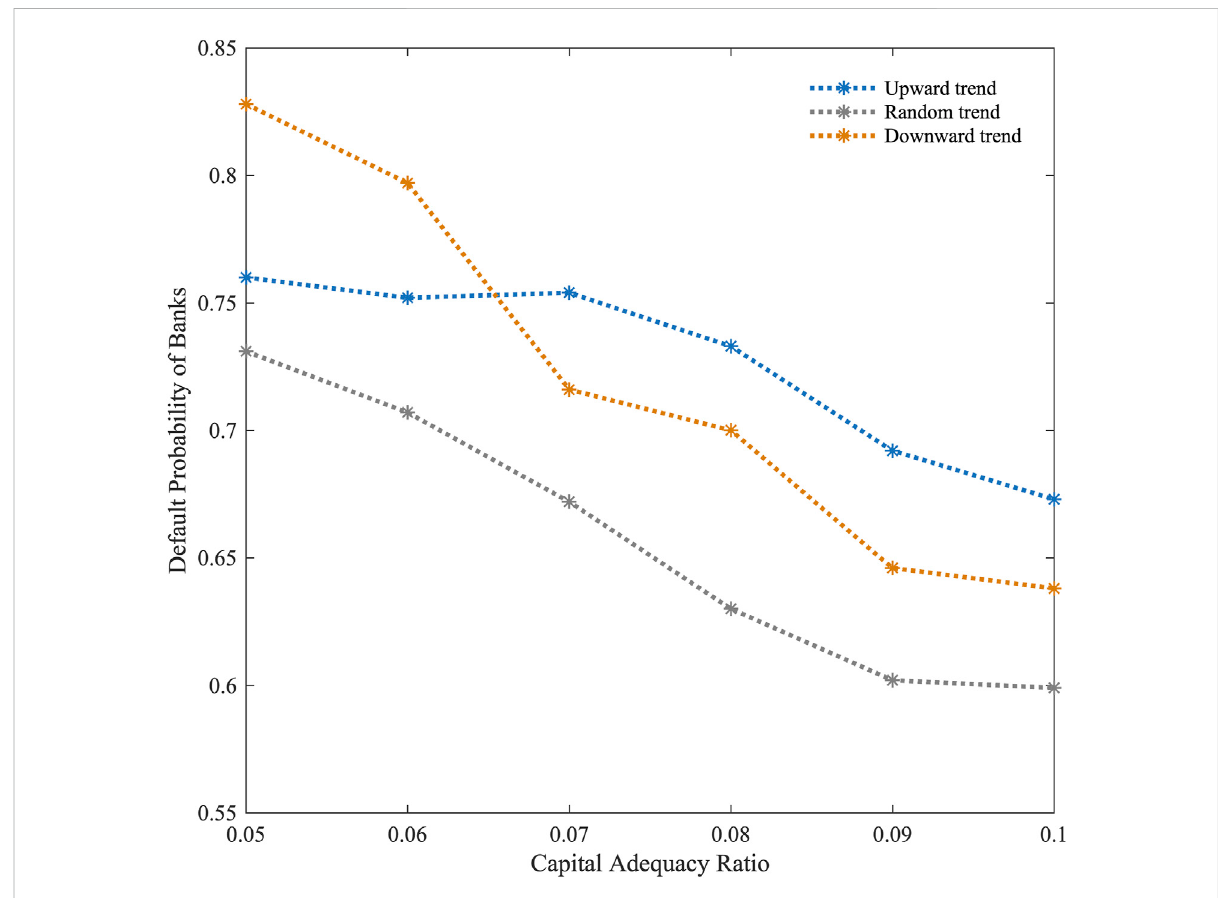
FIGURE 11 The default probability of banks with different capital adequacy